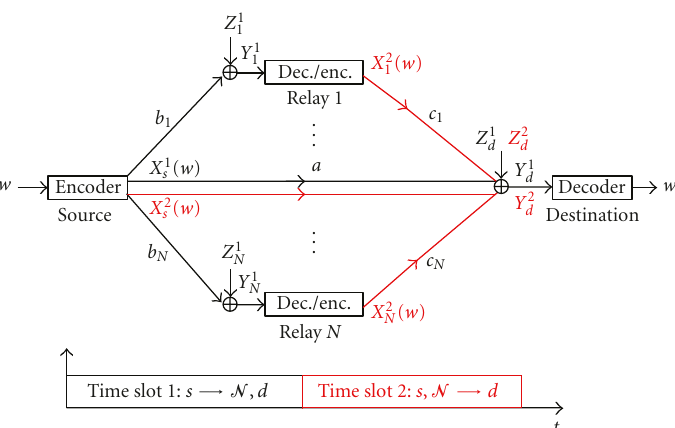
Figure 1: Half-duplex regenerative multiple relay channel with N parallel